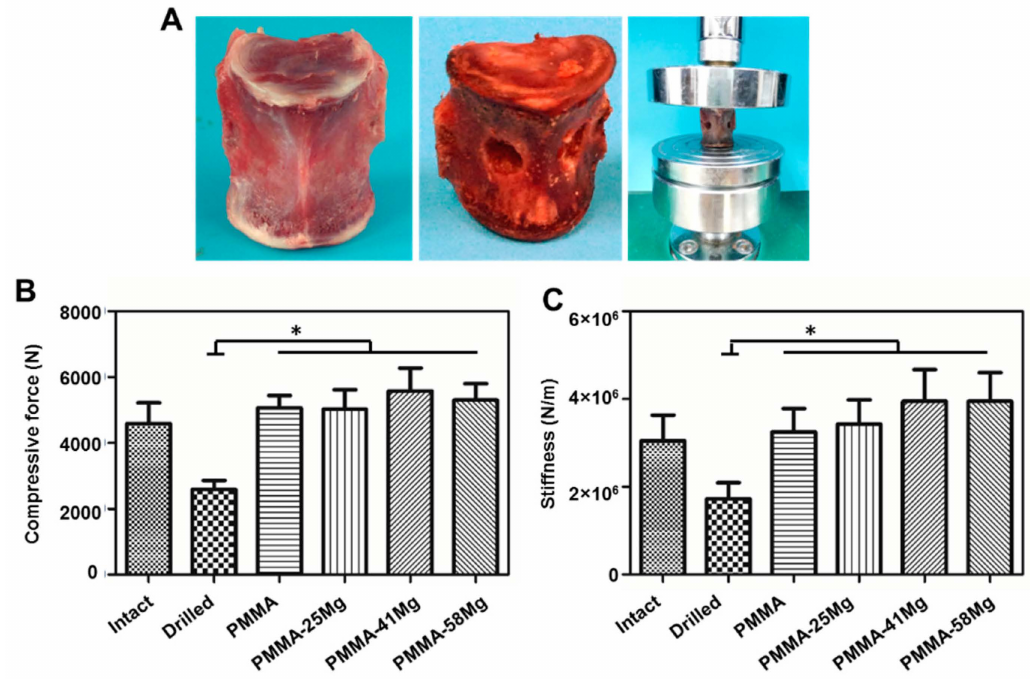
Figure 5. Vertebral body defect augmentation experiments with bone cement in vitro. ( A ) The gross morphology of vertebrae and drilled vertebrae and descriptive graph of the compressive test; ( B ) compressive strength and ( C ) stiffness of intact, drilled PMMA and PMMA–Mg cements filled vertebrae. * p <